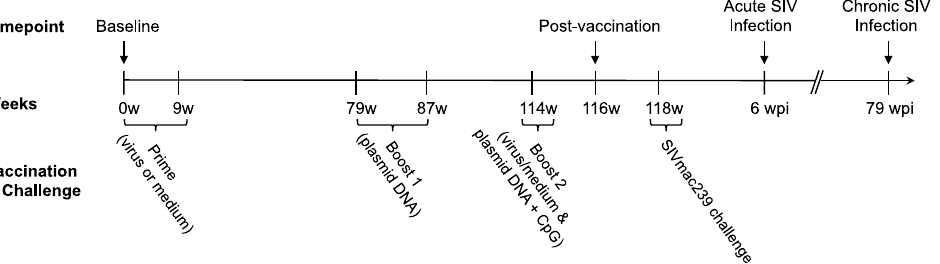
Figure 2. Vaccination schedule. Baseline PBMC samples were obtained prior to any vaccinations (week 0). The animals were primed at weeks 0 and 9 with viral constructs ( D 5-CMV, D 6-CCI) or medium only (control group). Animals were boosted with a DNA plasmid ( D 5-CMV, D 6-CCI or control) at weeks 79 and 87. A second boost comprised of both virus and plasmid accompanied by a CpG adjuvant was given at week 114. Post- vaccination PBMCs were isolated at week 116 and intrarectal SIVmac239 challenge was initiated at week 118. PBMCs were isolated during acute SIV infection (mean 6 weeks post-infection (wpi); range: 4–10 wpi) and during chronic SIV infection (mean 79 wpi; range 25–98 wpi) [20].